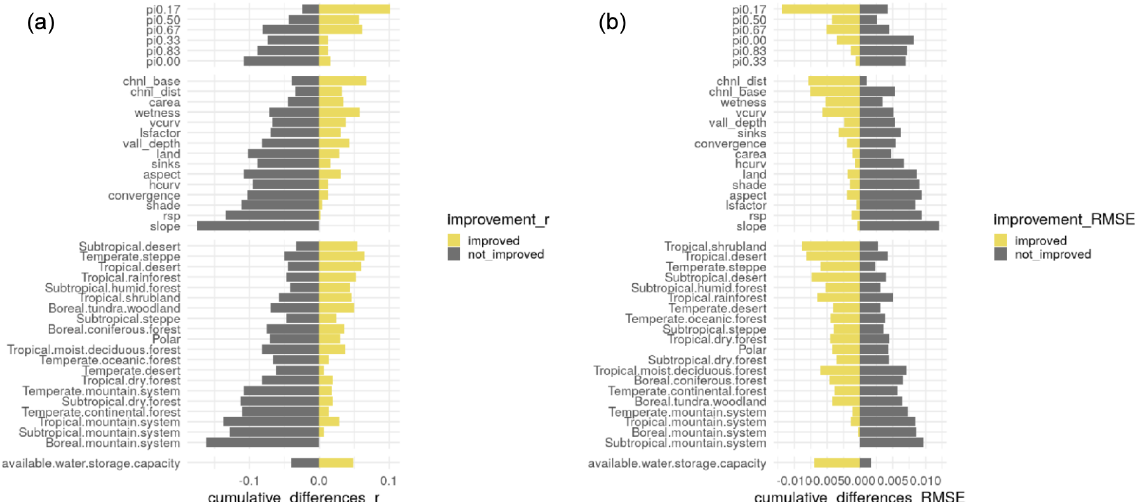
Figure 7. Impact of each factor on the (a) r and (b) RMSE values for the year 2018. The factors named pi0.00, pi0.17, pi0.33, pi0.50, pi0.67, and pi0.83 are the spatial coordinates at multiple angles shown in Fig. A2. The digital terrain parameters are shown in Fig. 3 and described by Guevara and Vargas (2019): aspect: terrain aspect; carea: specific catchment area; chnl base: channel network base level; chnl dist: distance to channel network; convergence: flow convergence index; hcurv: horizontal curvature; land: digital elevation model; lsfactor: length–slope factor; rsp: relative slope position; shade: analytical hillshade; sinks: smoothed elevation; slope: terrain slope; vall depth: valley depth index; vcurv: vertical curvature; and wetness: topographic wetness index. The bioclimatic features divided into (a) tropical, (b) subtropical, (c) temperate, or (d) boreal environments are represented by binomial variables (0–1). These variables are extracted by the Food and Agriculture Organization Global Agro-Ecological Zones project. The available water storage capacity variable is represented by continuous classes available thanks to the Regridded Harmonized World Soil